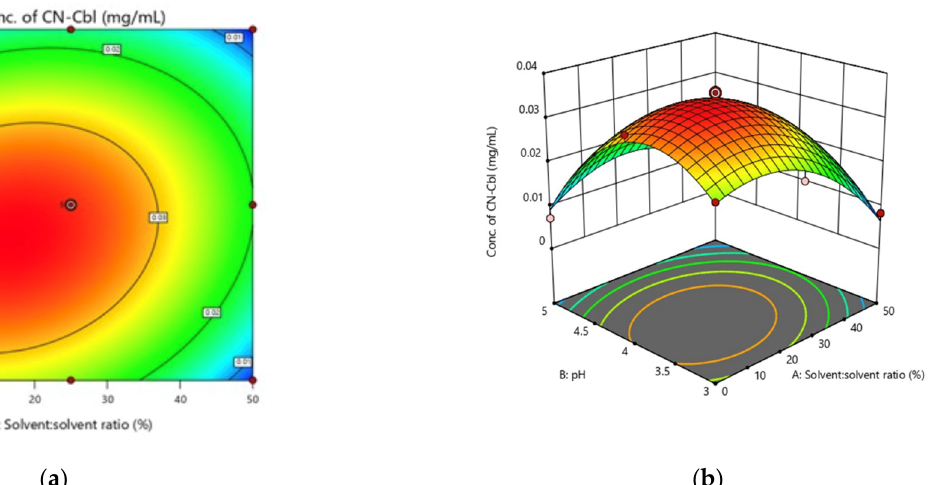
Figure 6. Surface response of the concentration of CN-Cbl recovered as a function of ( a ) AB interaction in contour plot and ( b ) AB interaction in the 3D surface plot.